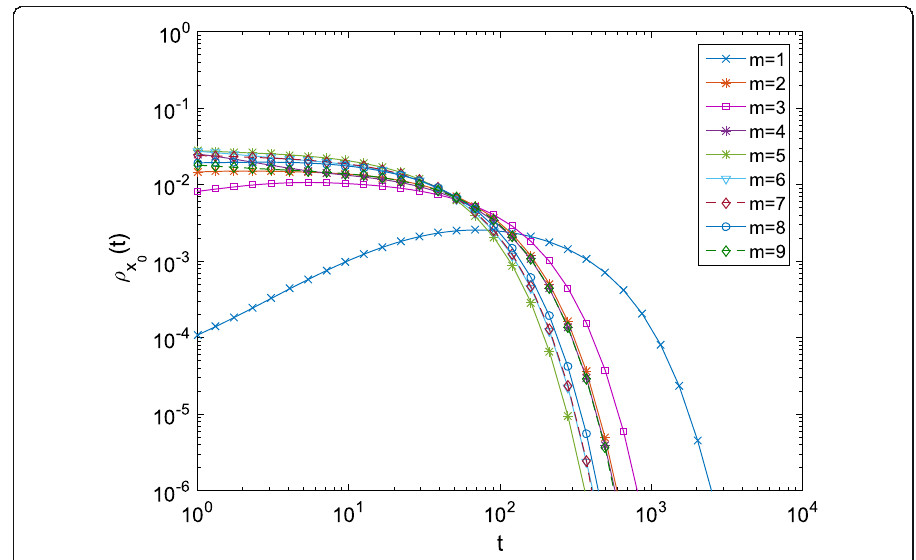
Fig. 4 FPT density for SF networks with parameters m 0 = 11 and m = 1 (tree SF network), m ∈ [2,9] (non-tree SF network) with N=100 nodes. Travel time distribution for all the nodes is ~ ψ xx 0 ð s Þ ¼ 1 = ð s τ þ 1 Þ ; τ = 1. The starting point x 0 and absorbing point x a are randomly chosen in each SF